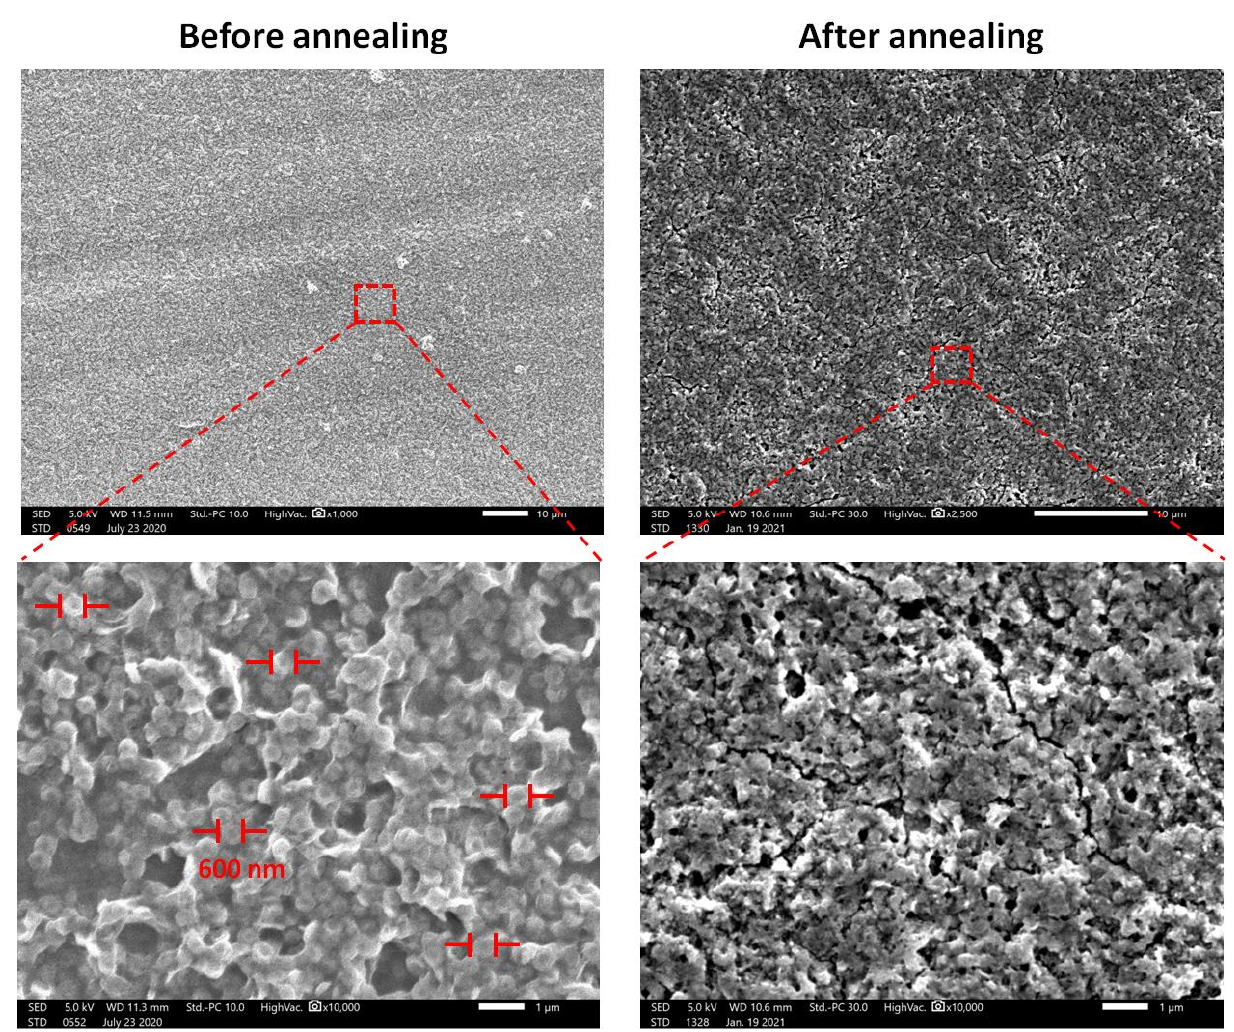
Figure 3. SEM images exhibiting the morphology of the ZnO seed layer before and after annealing.